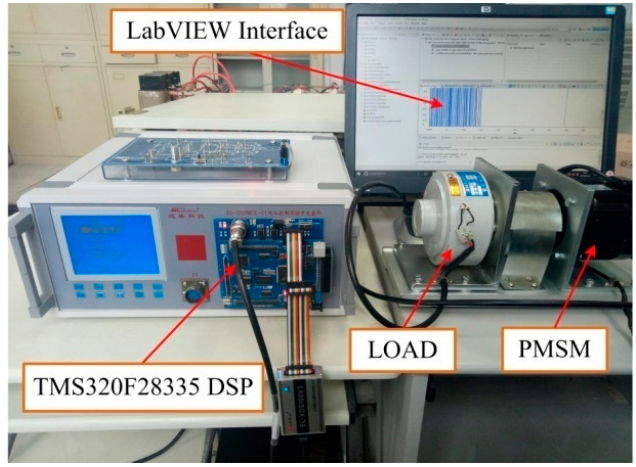
Figure 11. Experimental setup of control system.